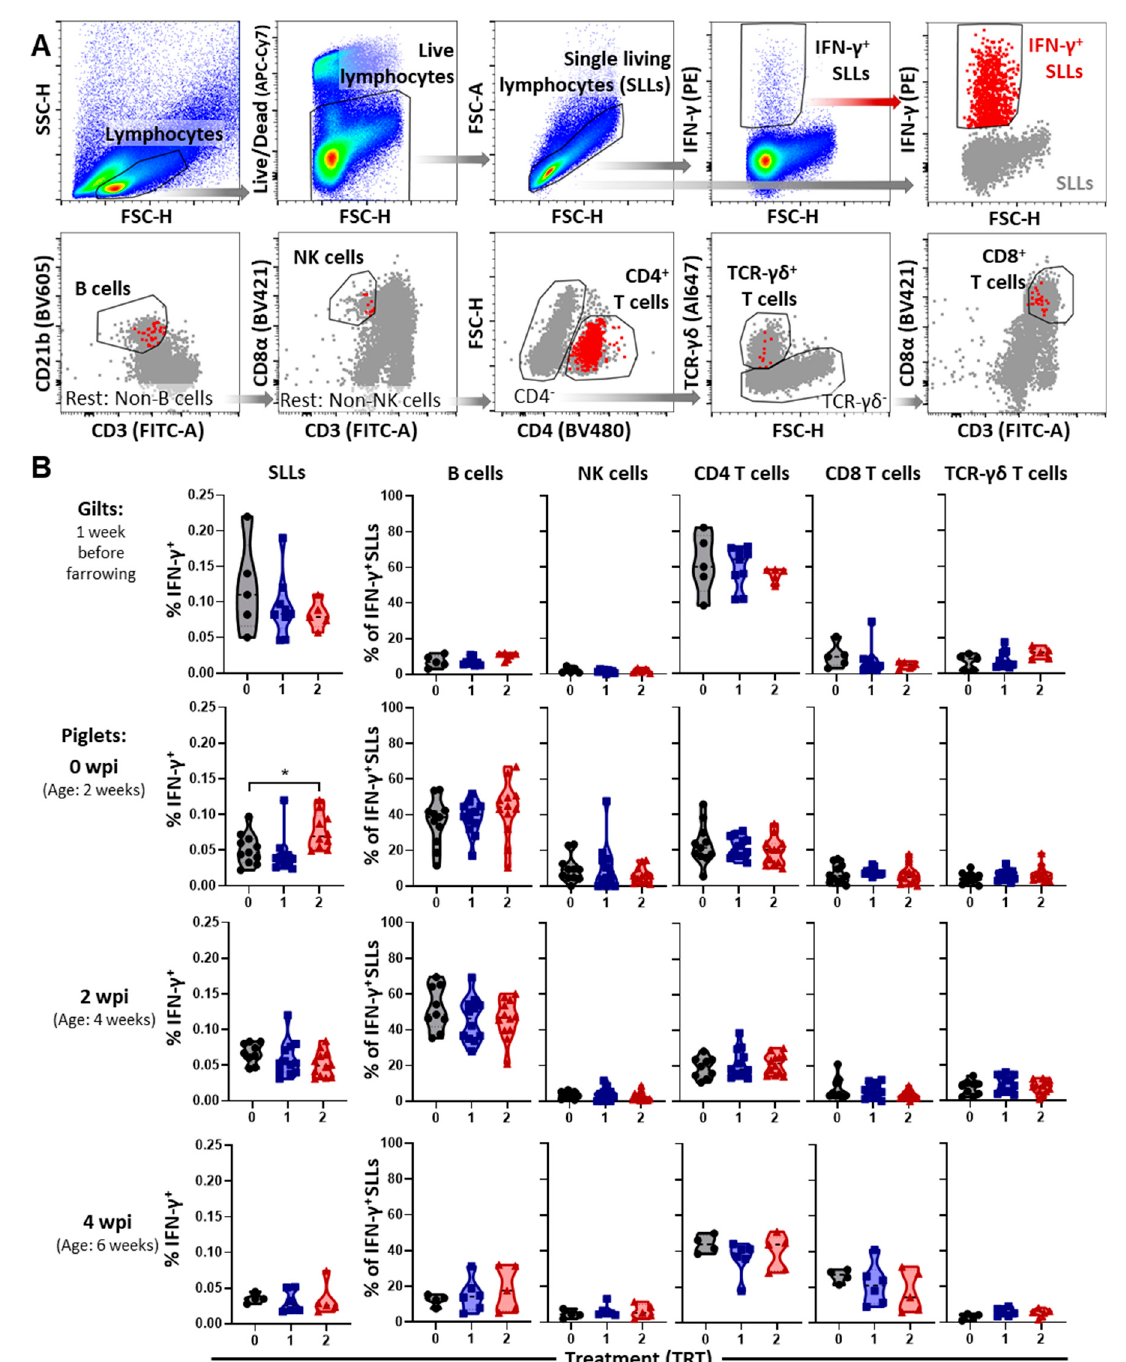
Figure 4. The systemic IFN- γ response to PRRSV 1-7-4 in gilts and their offspring: ( A ) shows the gating hierarchy starting with a forward/ side scatter (FSC/SSC) gate on lymphocytes, the exclusion of dead cells and doublets to focus the analysis of IFN- γ production on single living lymphocytes (SLLs). Subgates on B cells, NK cells, CD4, CD8 and TCR- γδ T cells were drawn on the whole SLL population (in gray) and overlaid by IFN- γ producing cells (in red). ( B ) shows the IFN- γ production as a percentage of all SLLs (left column) and the percentage of each immune cell subsets contributing to this IFN- γ production (all other columns). Data were analyzed via one-way ANOVA with Dunnett’s multiple comparisons. Significant differences between treatments are designated as * p < 0.05.